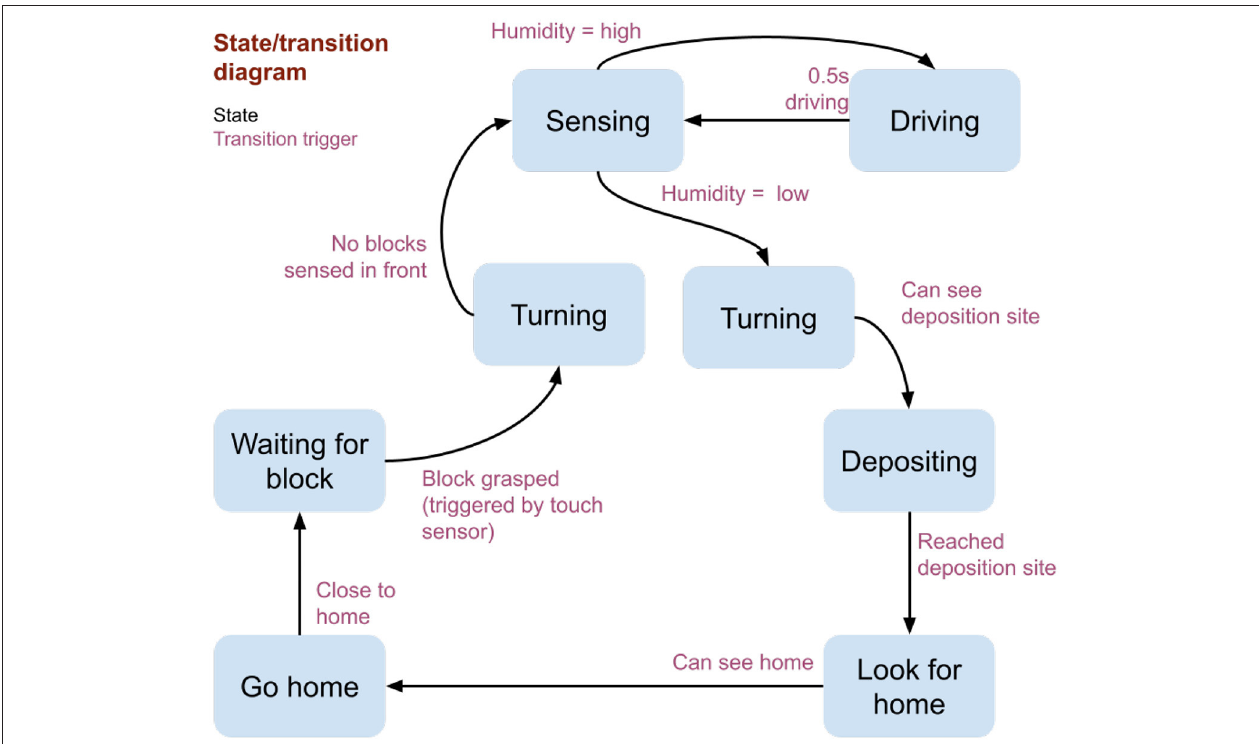
FIGURE 3 | State and transition diagram used by the robot termite. Blue boxes indicate the robot states, and transition arrows between each state are labeled with the fulfillment